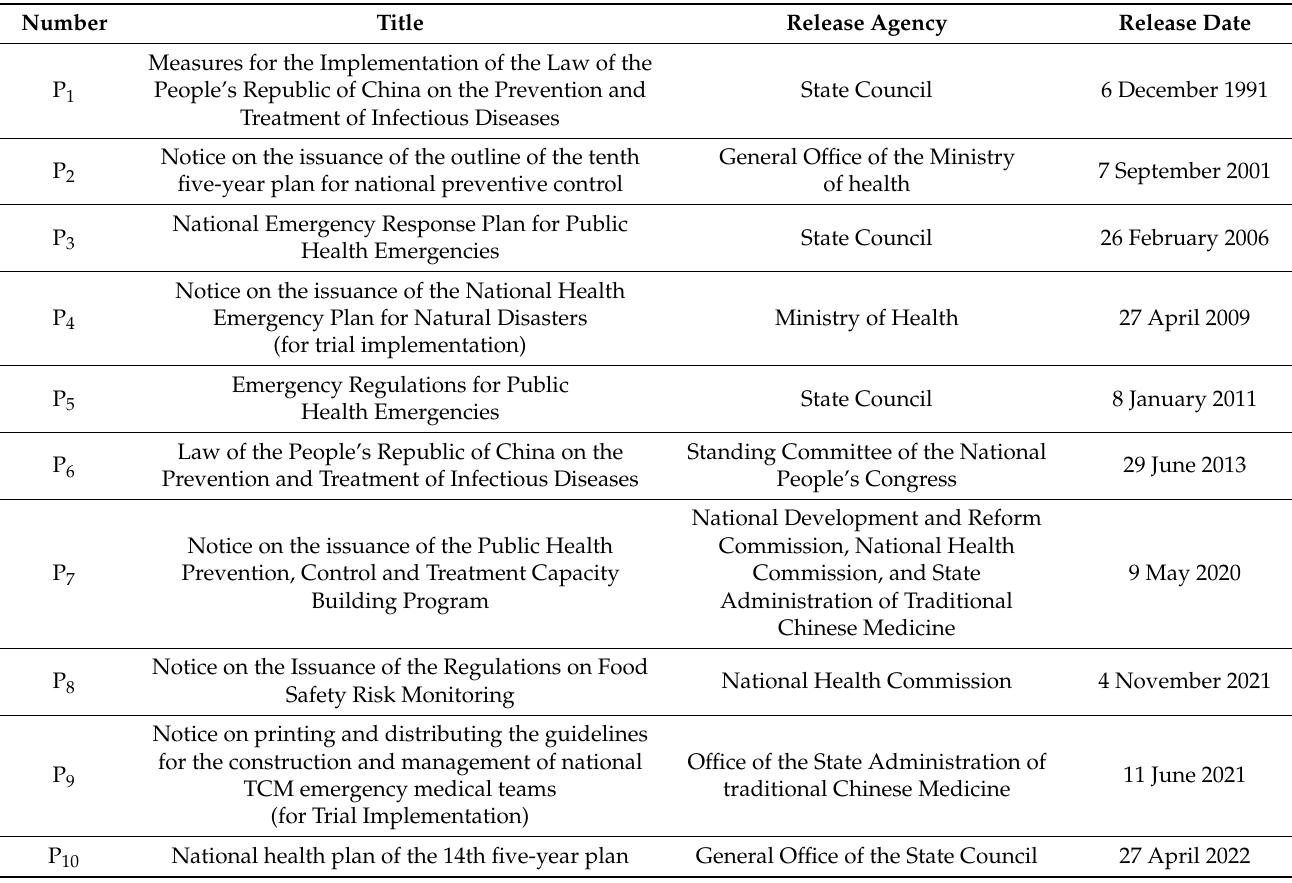
Table 2. Selected policy